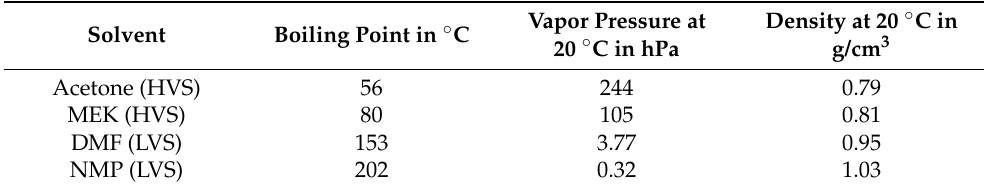
Table 1. Properties of the different solvents used for fabricating polymer films. Values for boiling point, vapor pressure and density are taken from the manufacturer’s data.